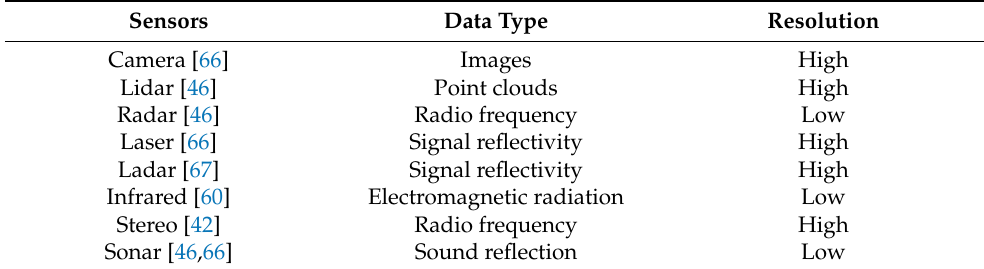
Table 5. The sensors usually used for